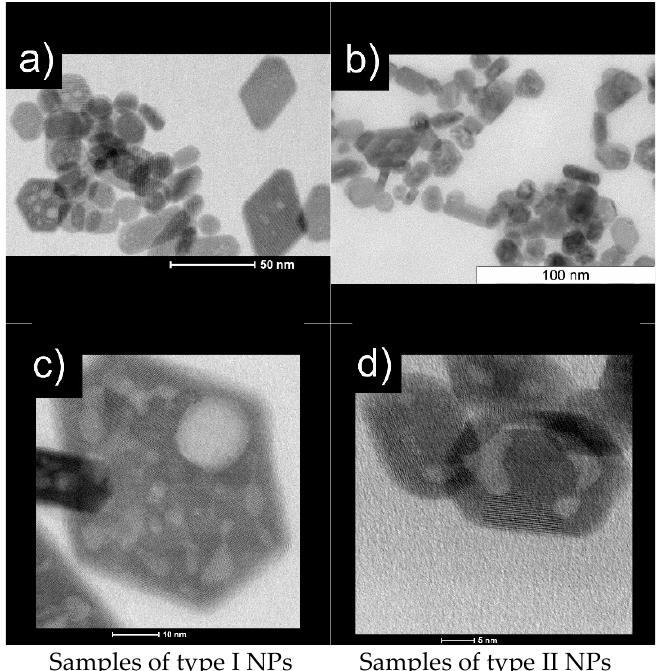
Figure 1. S TEM images of Nd 3+ : LaF 3 NPs: - samples of type I are on the left ( a , c ); samples of type II Figure 1. STEM images of Nd 3+ : LaF 3 NPs: samples of type I are on the left ( a , c ); samples of type II are on the right ( b , d ). are on the right ( b , d ).